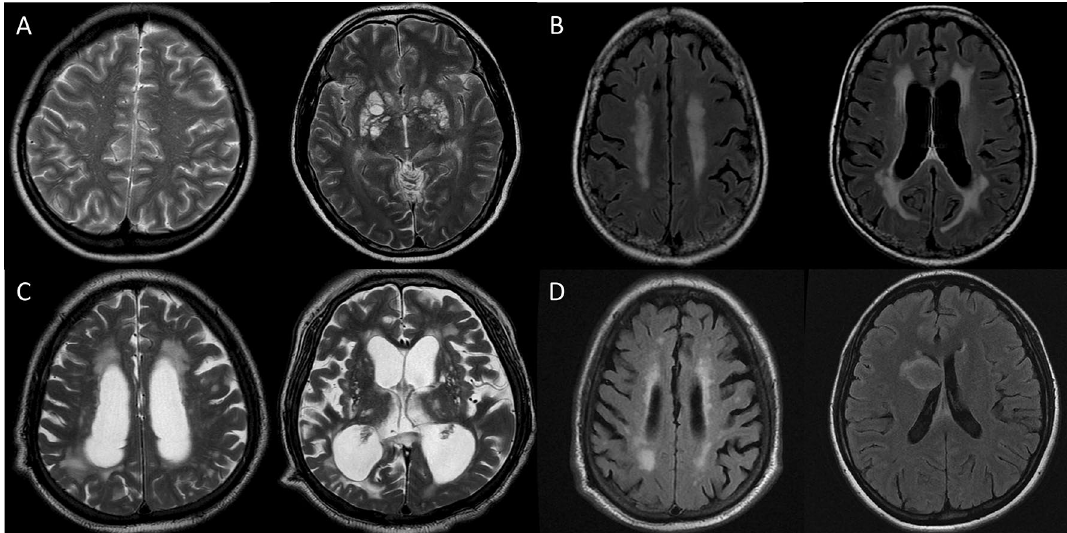
Figure 1. Examples of the brain MRI findings associated with cryptococcus meningoencephalitis. Panel ( A ), enlarged periventricular space (ePVS) in centrum semiovale (> 40 EPVS, score = 4, left panel) and basal ganglia (> 40 EPVS, score = 4, right panel); Panel ( B ), periventricular extension of the T2 high-signal intensity (HSI) on T2 fluid attenuated inversion recovery (FLAIR) images; Panel ( C ), hydrocephalus (Evans ratio = 0.42); and Panel ( D ), development of multiple cryptococcomas in right parietal cortex (left panel) and right caudate nucleus (right panel, T2 FLAIR